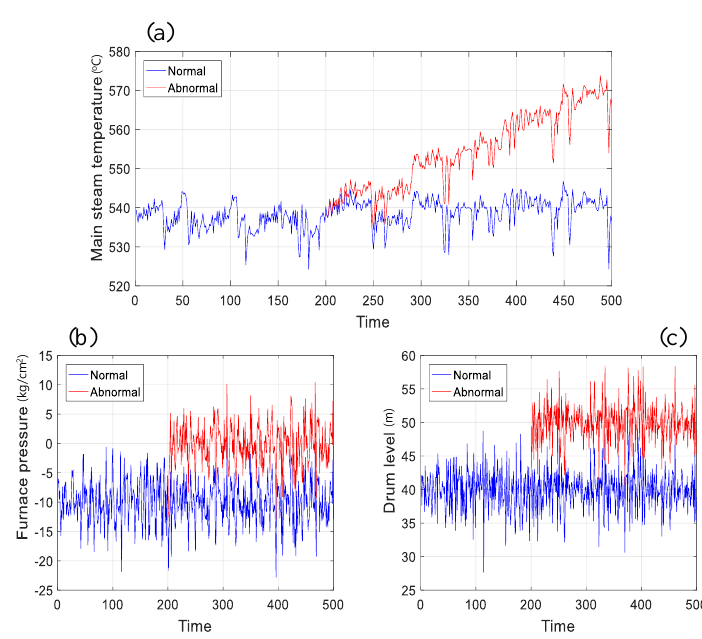
Figure 8. (Artificial fault cases) Behaviors of faulty variables: ( a ) (Case 1) main steam temperature (°C) ( x 4 ); ( b ) (Case 2) furnace pressure (kg/cm 2 ) ( x 6 ); ( c ) (Case 2) drum level (m) ( x 7 ).